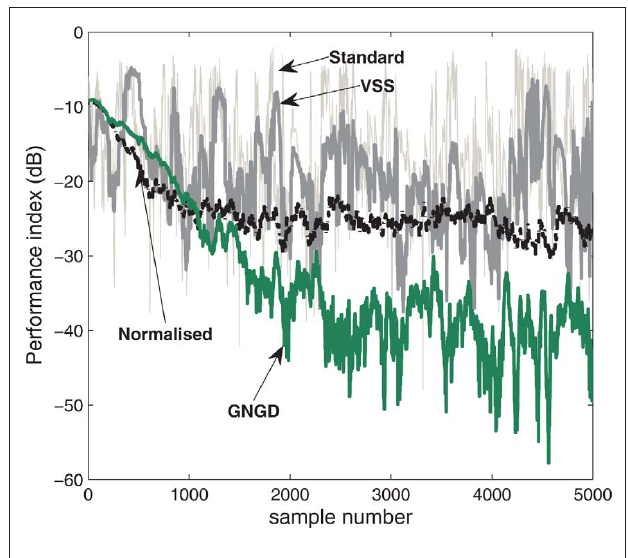
FiGurE 4 | Comparison of the effect of step-size adaptation on the performance of algorithm (22) for the extraction of a single source.